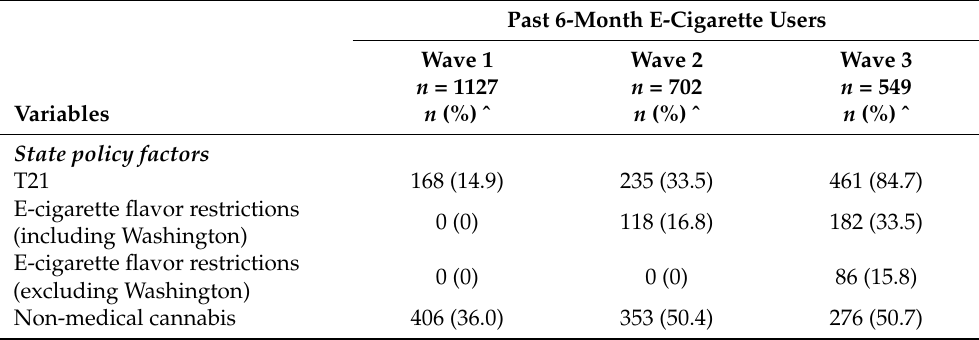
Table 2. Characteristics of past 6-month e-cigarette users who visited vape shops